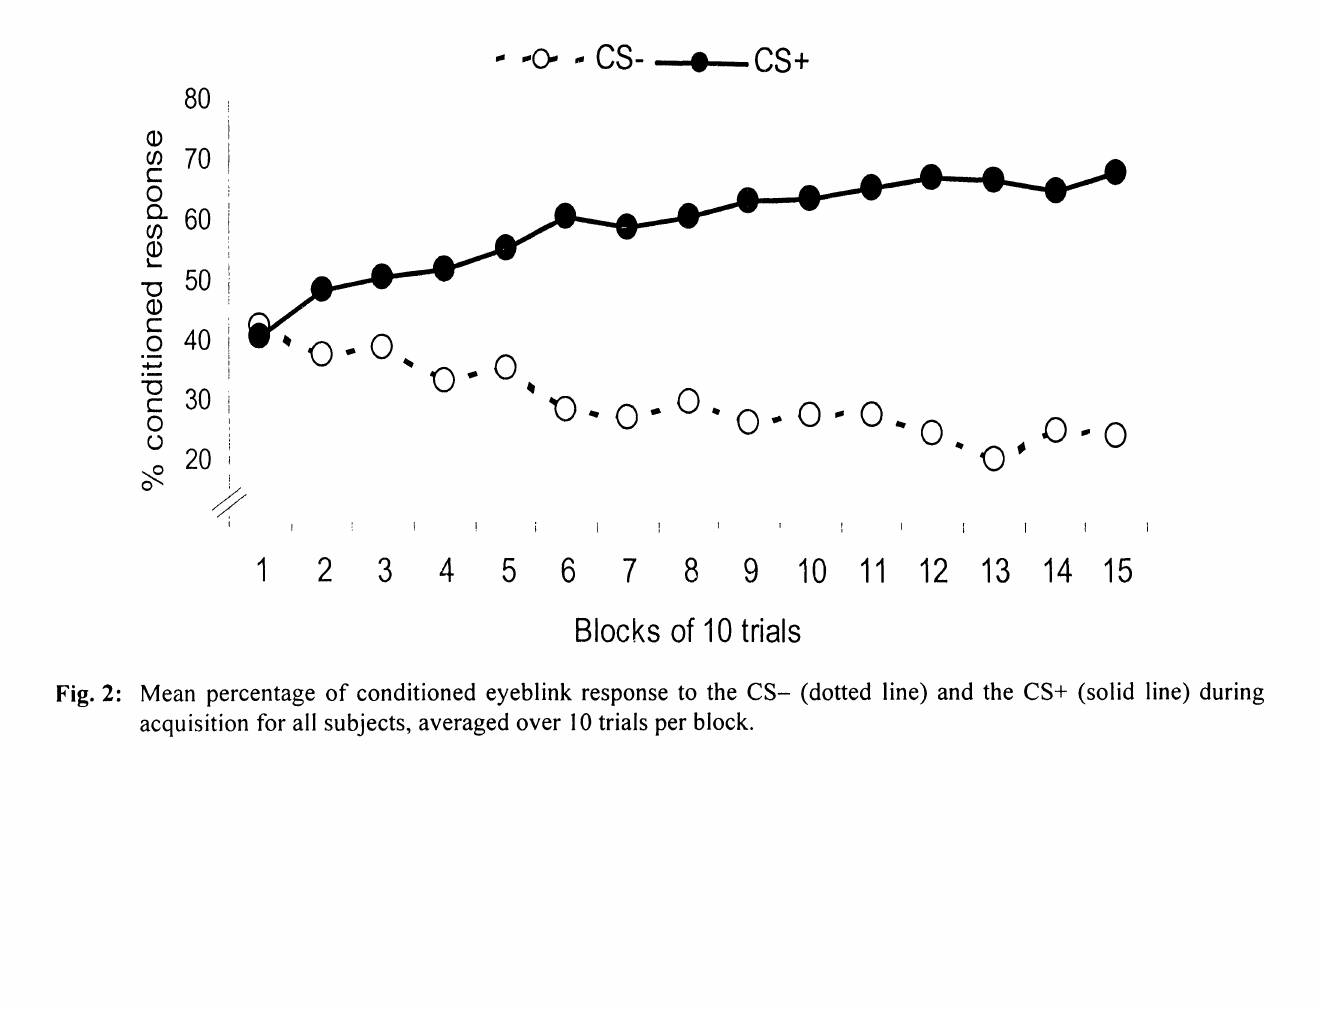
Fig. 2" Mean percentage of conditioned eyeblink response to the CS- (dotted line) and the CS+ (solid line) during acquisition for all subjects, averaged over 10 trials per